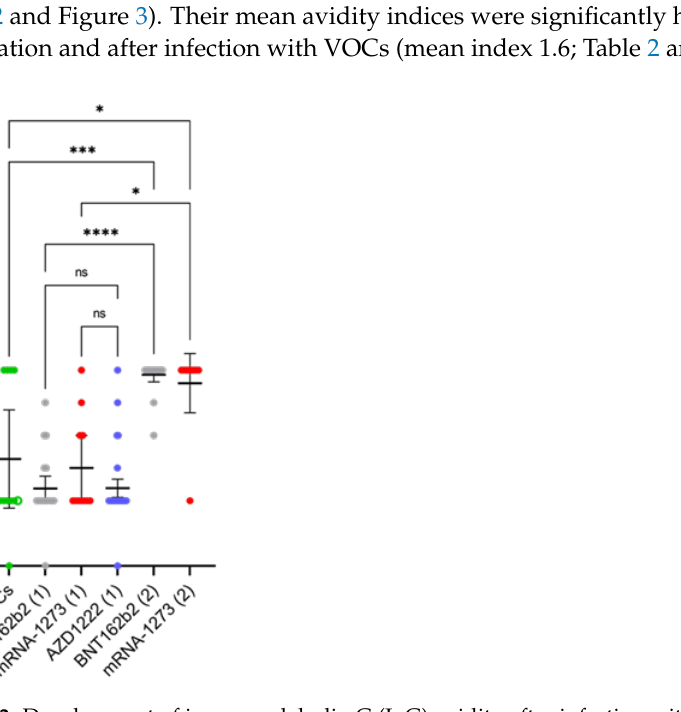
of concern (VOCs: B.1.1.7, filled green dots; B.1.351, empty green dot) or after first (1) or second (2)